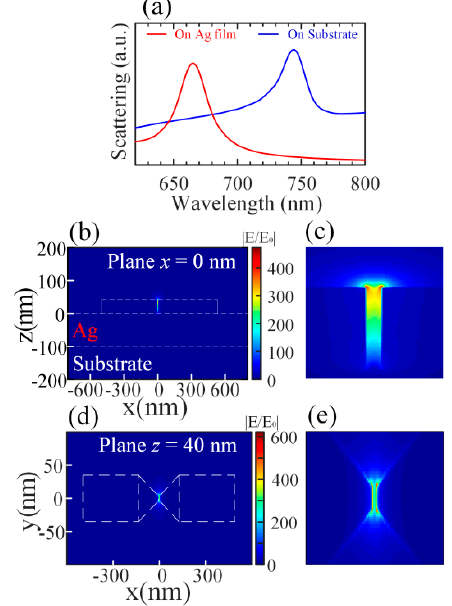
Figure 2. ( a ) Simulated scattering spectra of the silver nanoantenna placed on a silver film (red line) and directly on a silica substrate (blue line). ( b ) The electric field distribution of the longitudinal mode on the plane x = 0 for the silver nanoantenna placed on the silver film. ( c ) The magnified electric field distribution in the nanogap in ( b ). ( d ) The electric field distribution of the longitudinal mode on the plane z = 40 nm for the silver nanoantenna placed on the silver film. ( e ) The magnified electric field distribution in the nanogap in ( d ). The color bars indicate the electric field enhancement.